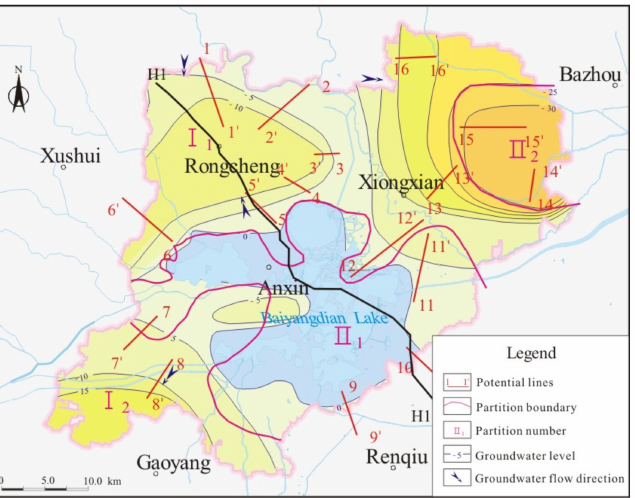
Figure 3. Potential lines of shallow water and subzones of the study area divided according to the groundwater chemical kinetics.